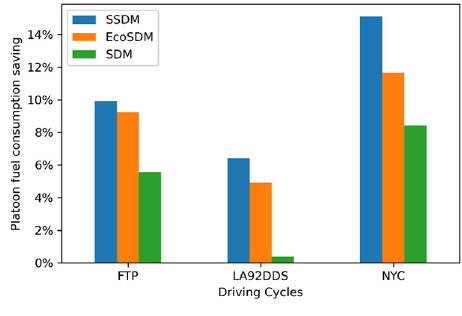
Figure 4 Platoon-level fuel saving of CAVs with different driving cycles